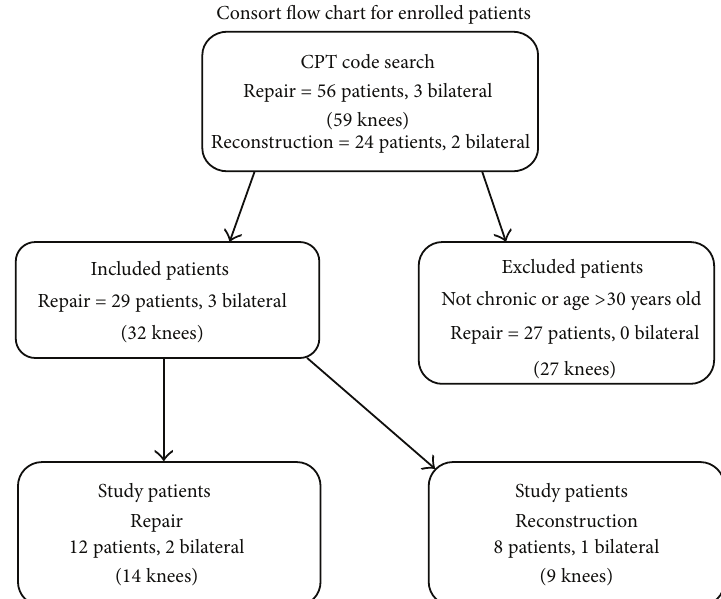
Figure 1: Consort diagram demonstrating patient inclusion and exclusion.